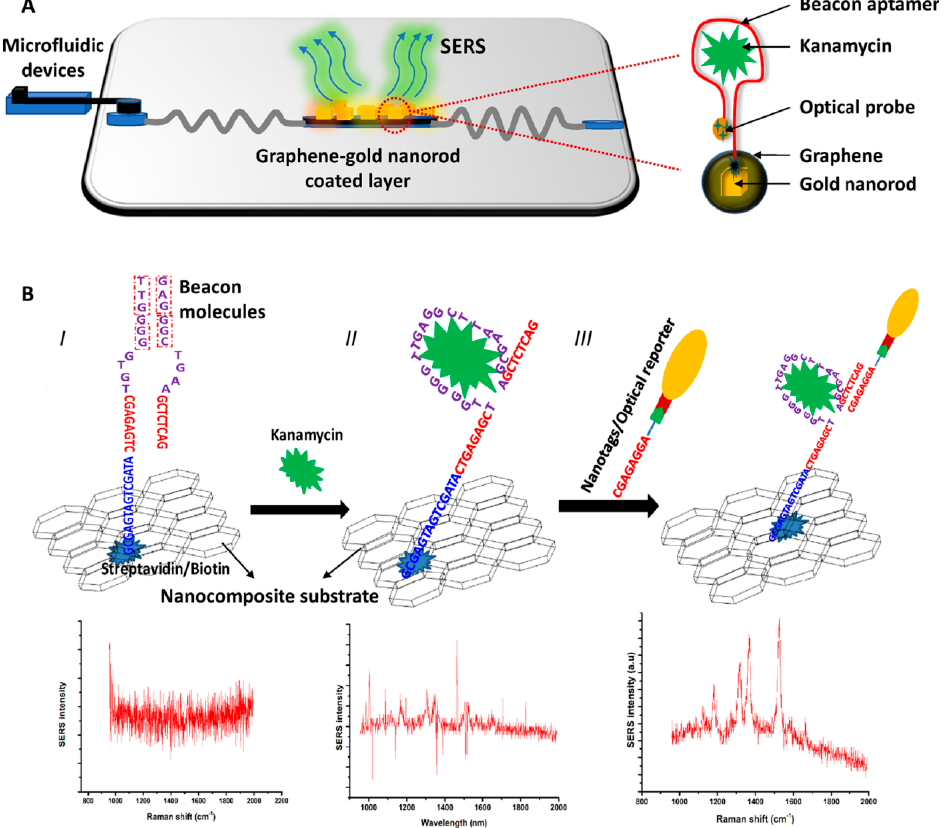
Figure 13. Scheme of the experimental platform for KANA detection. ( A ) Scheme of the experimental platform; ( B ) Illustration of the principle of the indirect assay. (Reprinted with permission from Elsevier, 2019 [44]).